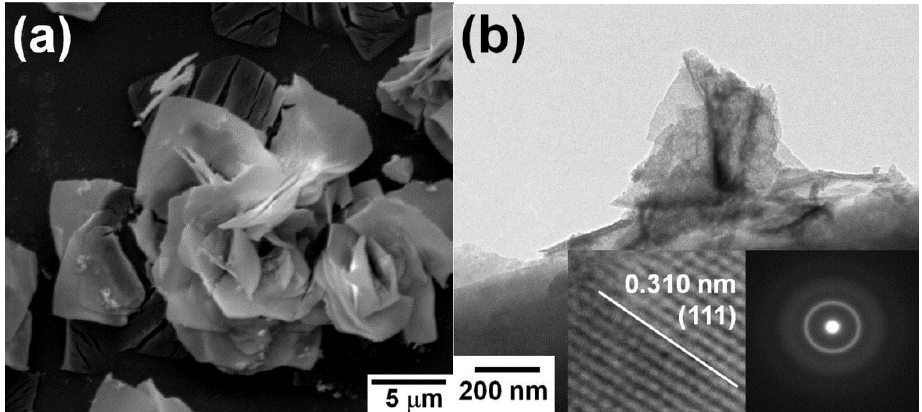
Figure 17. ( a ) Scanning electron microscopy image and ( b ) TEM image of the CeO 2 nanopetaled rose-flower-like morphology annealed at 300 °C for 3 h. Insets present a high-resolution TEM image and a selected-area electron diffraction pattern of the CeO 2 roses. Reproduced from Ref. [172] with the permission from the American Institute of Physics.